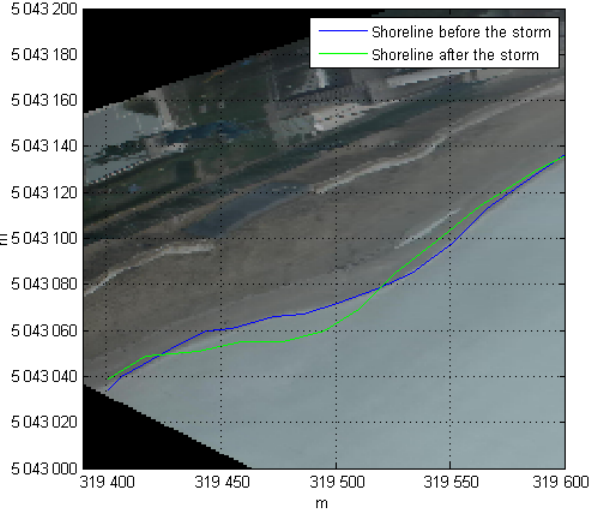
Figure 11. Detected shorelines, before and during the 7th